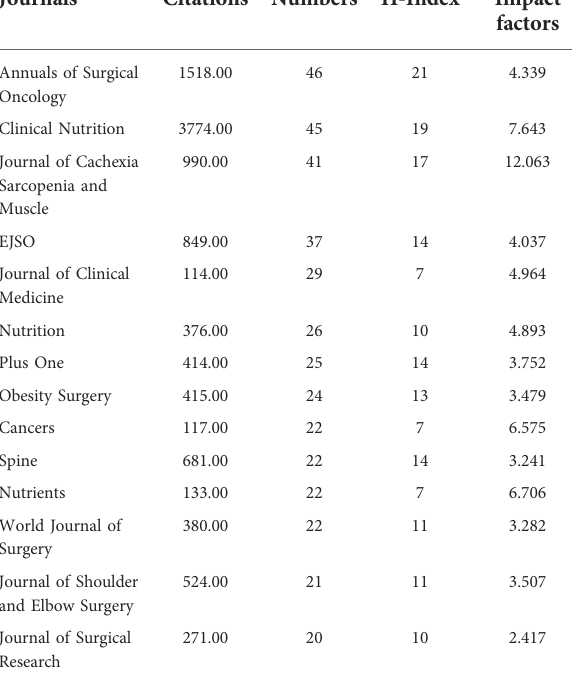
TABLE 4 The top 10 most productive authors focusing on the relationship between sarcopenia and surgery.